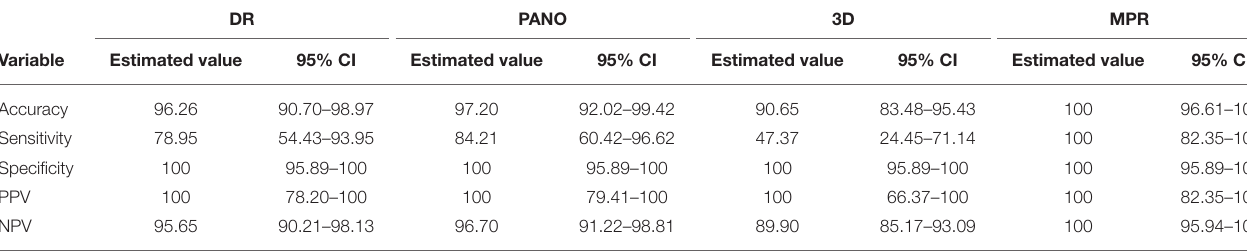
TABLE 7 | Ability to identify buccal bone expansion in cats by use of dental radiography (DR method) and 3 CBCT software modules * .